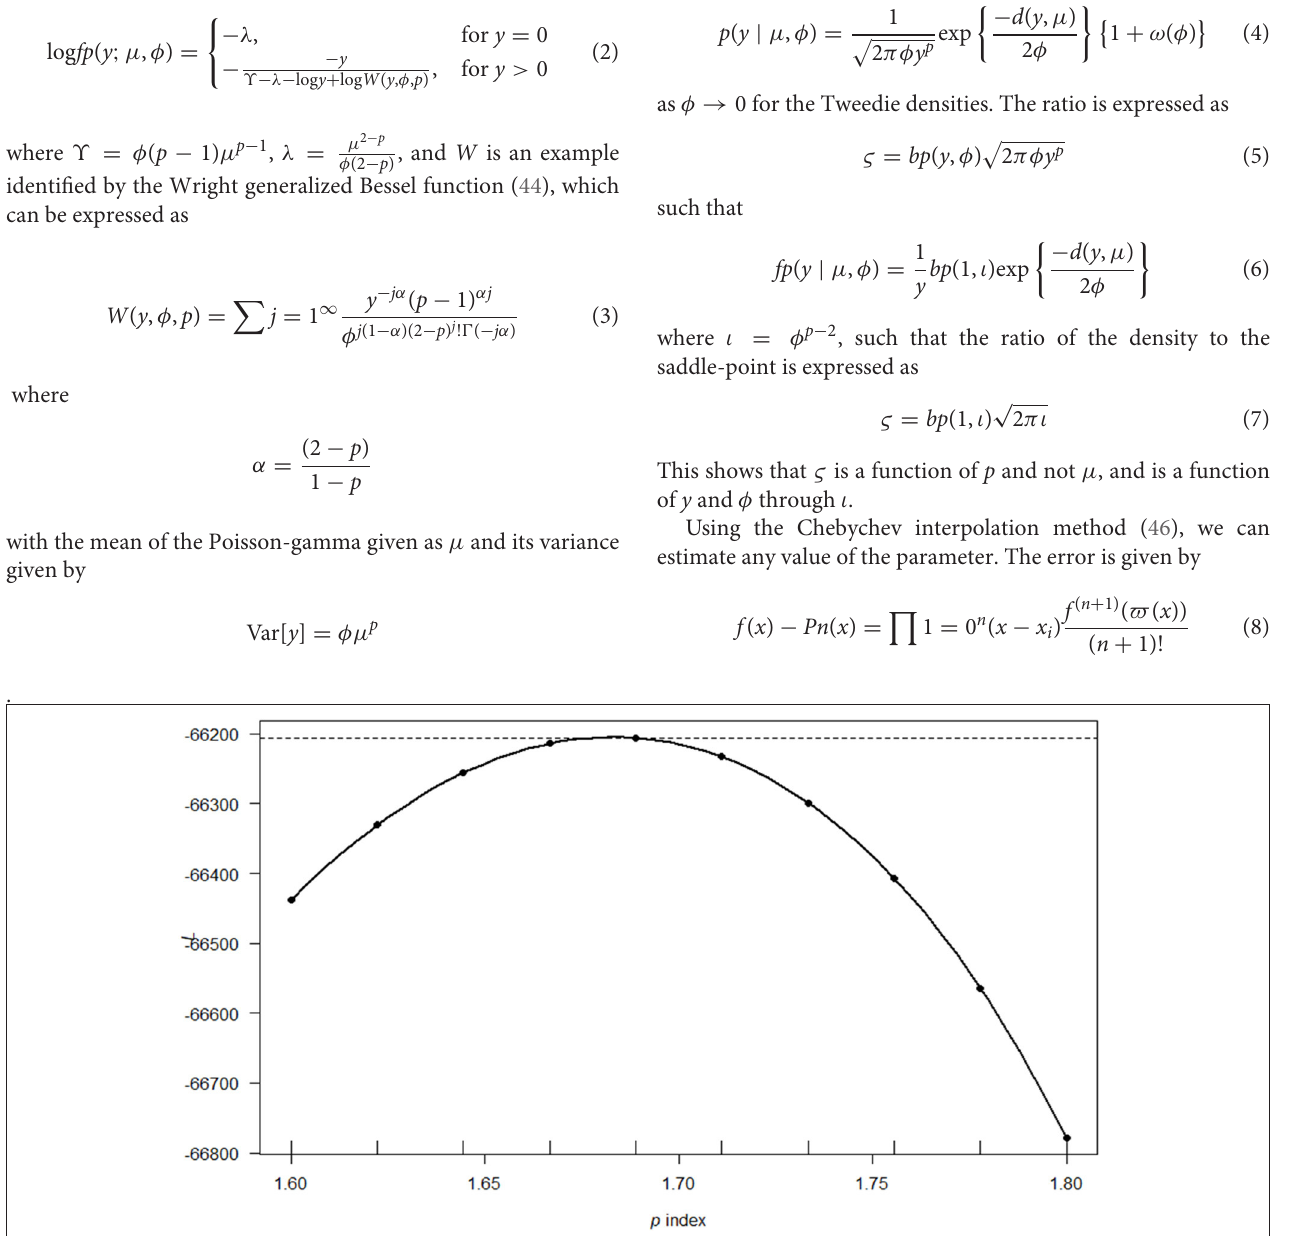
FIGURE 1 | The profile log-likelihood plot for cost of outpatient care in Kenya using the Model 1 covariates. The solid line is a saddle-point approximation of the P index from the data with a value of 1.68 and estimated 95% confidence interval [1.67,1.69].